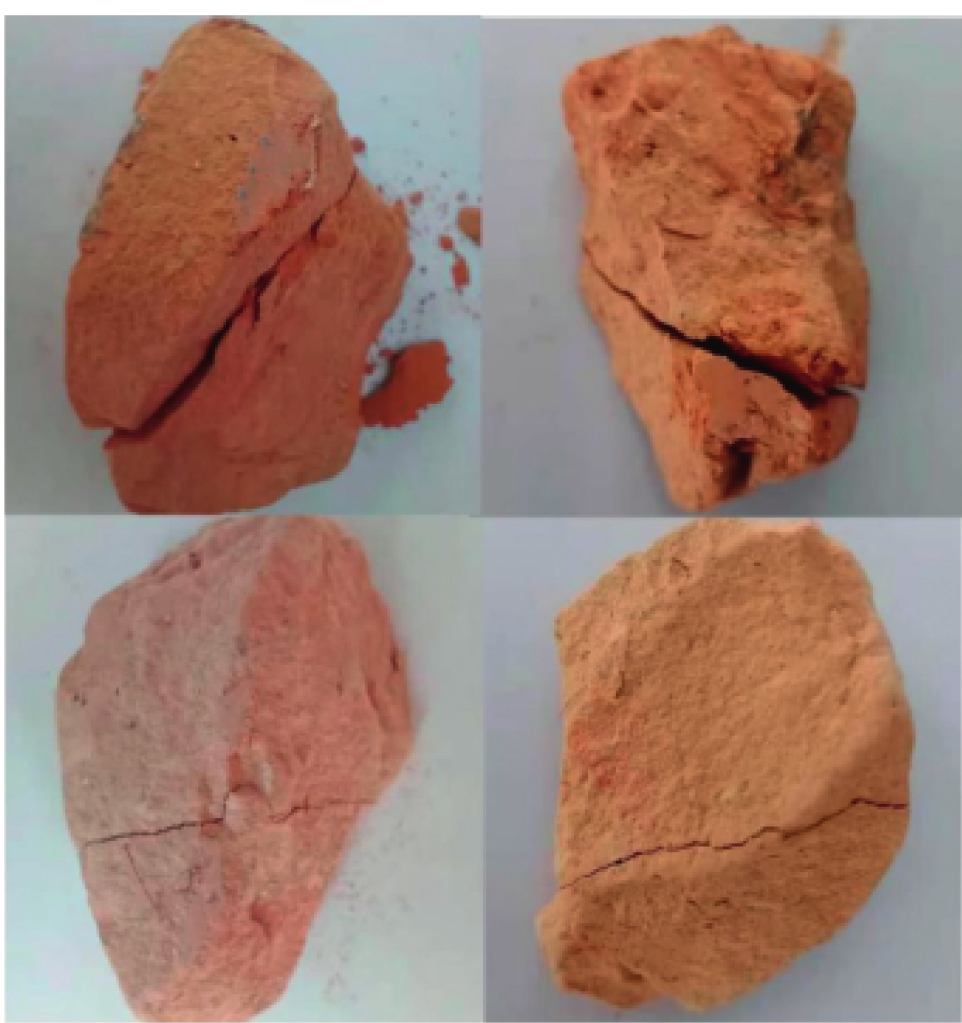
Figure 4: Crushing mode of recycled brick